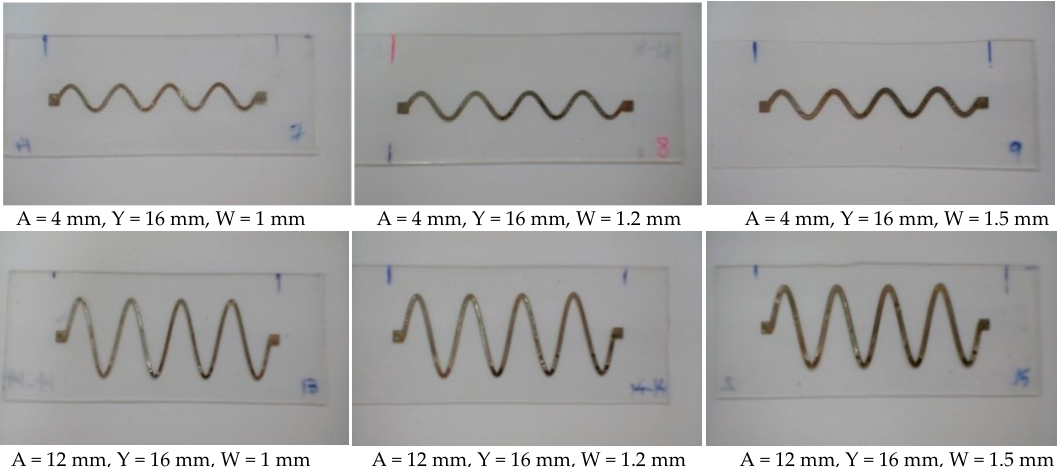
Figure 7. Sinusoidal conductive patterns printed on PDMS at various amplitudes and line widths.